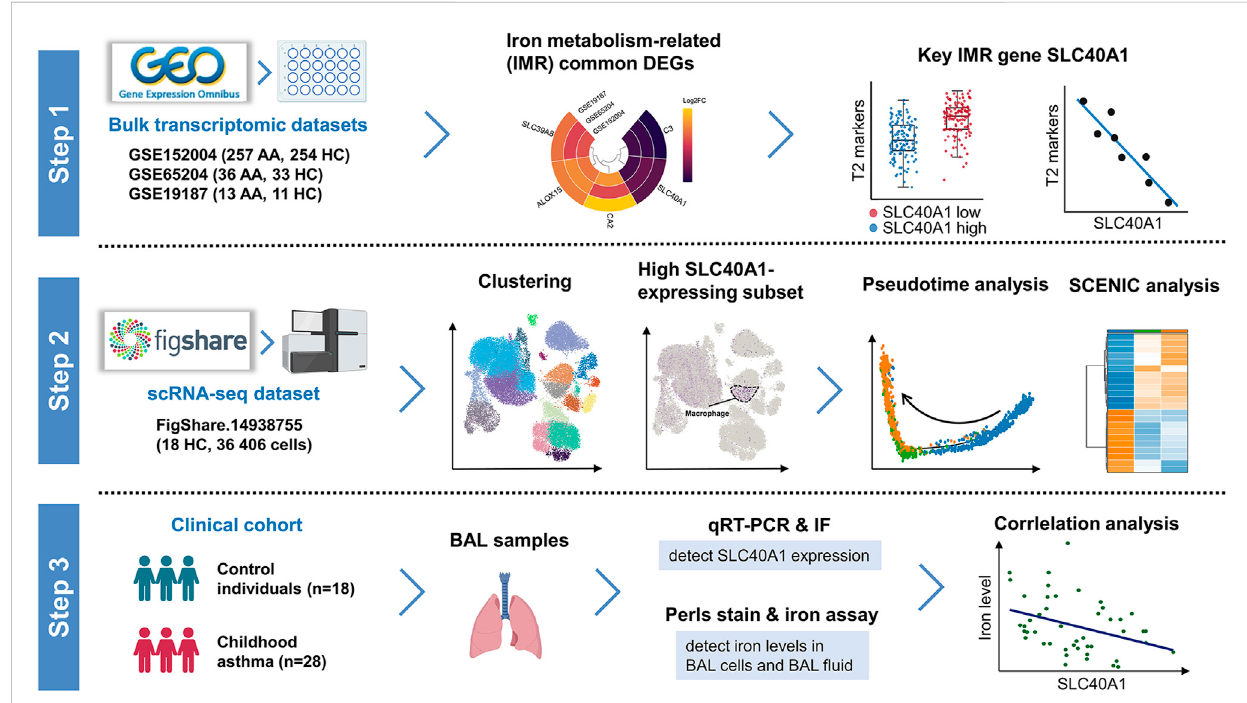
FIGURE 1 Schematic work fl ow of study design. Step 1: Identi fi cation of SLC40A1 as the key IMR DEG in childhood allergic asthma by bulk transcriptomic analysis. Step 2: Single-cell transcriptomic analysis revealed high SLC40A1-expressing cell subsets. Step 3: Validation of SLC40A1 expression and explorationofitsinvolvementinalteredironlevelsintheairwaysofchildrenwithallergicasthma.AA,allergicasthma;BAL,bronchoalveolarlavage;DEGs, differentiallyexpressedgenes;FC,fold-change;HC,healthycontrol;IF,immuno fl